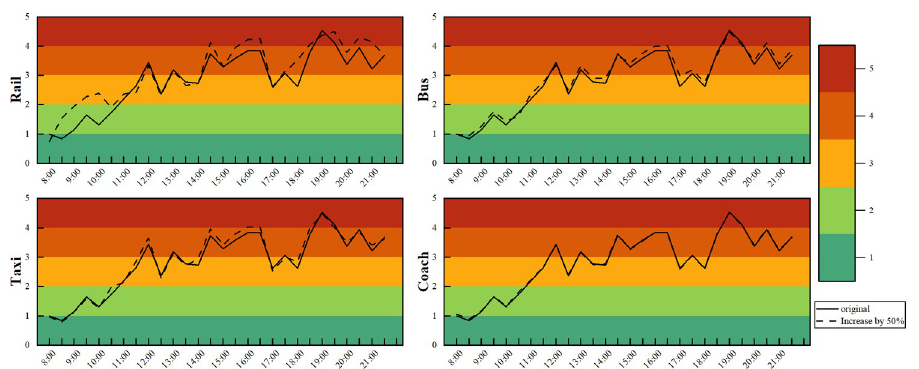
Fig 10. Comparison chart of the passenger flow efficiency evaluation in each connection